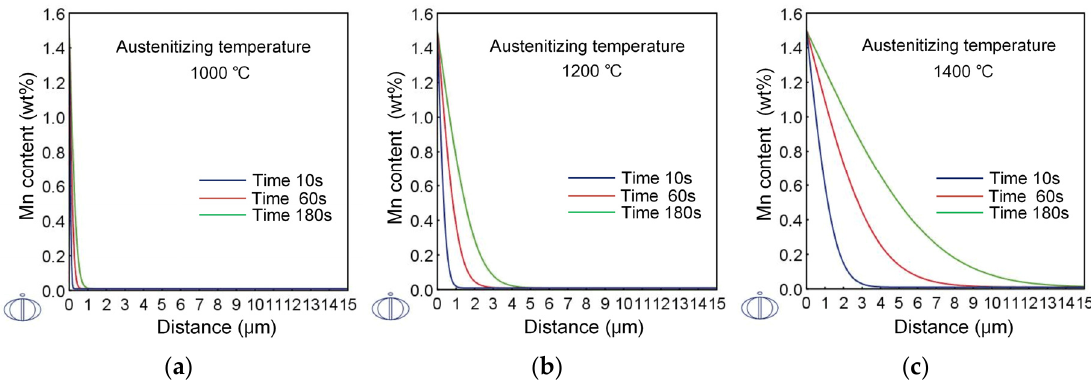
Figure 8. Diffusion distance of Mn in austenite at different ( a ) 1000 °C, ( b ) 1200 °C and ( c ) 1400 °C.